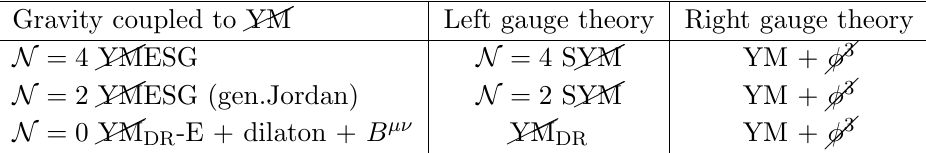
Table 2 . New double-copy constructions corresponding to spontaneously-broken YME gravity theories for di(cid:11)erent amounts of supersymmetry. The dimensionally-reduced YM DR theory must have at least one scalar to provide the VEV responsible for spontaneous symmetry breaking. See